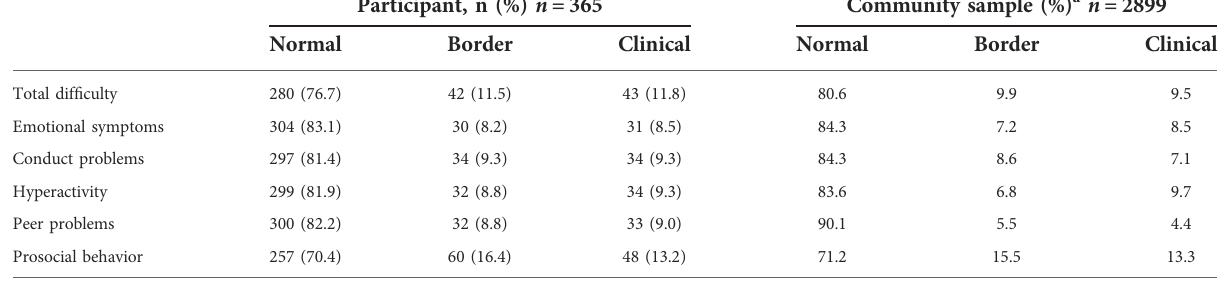
TABLE 3 Distribution of SDQ score in the study participants and the community